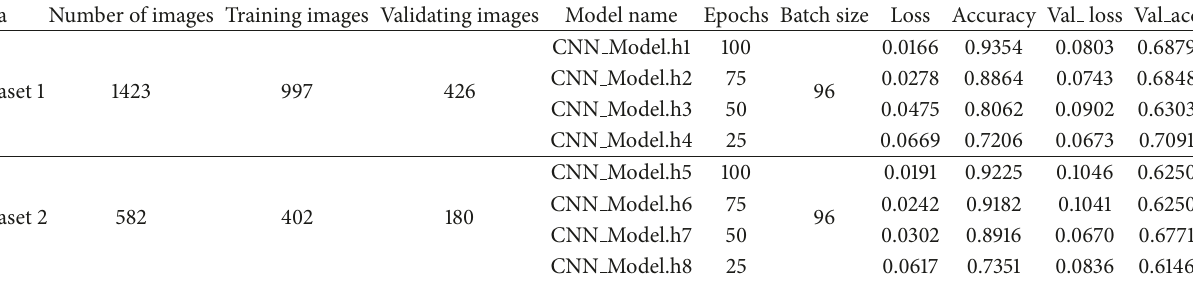
Table 6: CNN models training results.